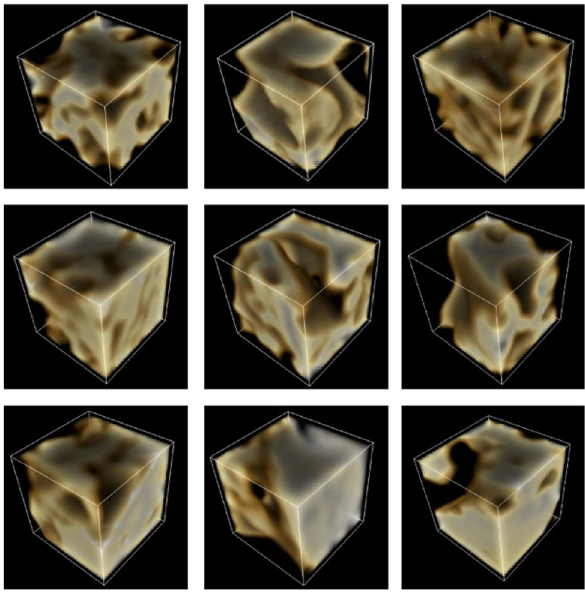
Fig. 13 Examples of class 6